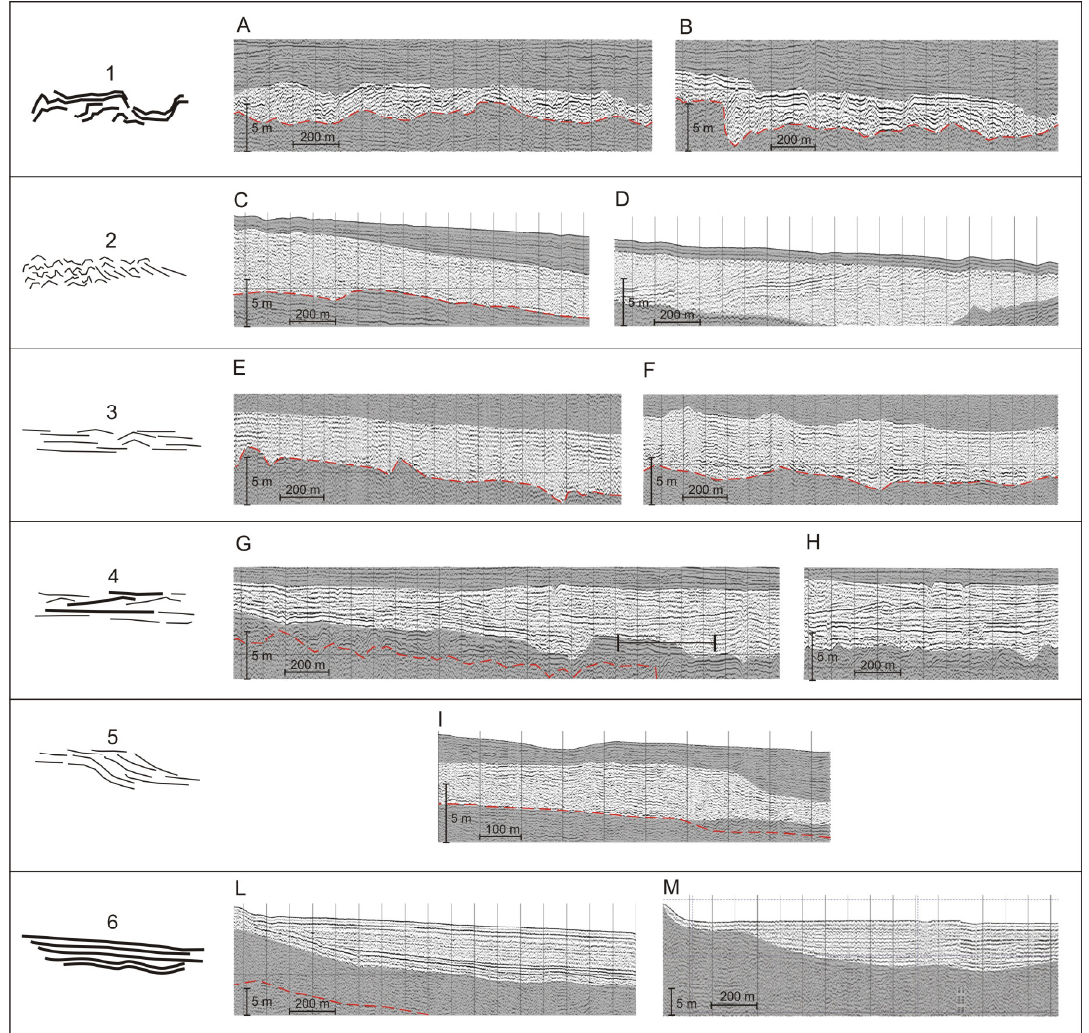
Figure 8. Examples of the seismic facies recognised in the study area in the sparker profiles. On the left the six seismic facies are drawn, with the corresponding number; the drawings roughly summarize the main characteristics of the facies. On the right are examples of each seismic facies, taken from the studied profiles. ( A , B ): facies 1; ( C , D ): facies 2a and 2b, respectively; ( E , F ): facies 3; ( G , H ): facies 4; I : facies 5; ( L , M ): facies 6. The shaded areas cover seismic facies different from that described in each row. The red dashed line represents the ES1. All the profile segments shown are along valleys except that of box A, which is across the IV2.